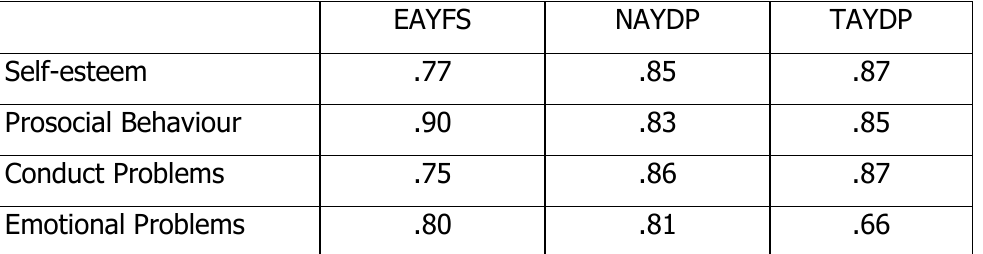
Comparison of Internal Consistencies of Scales for Various Studies